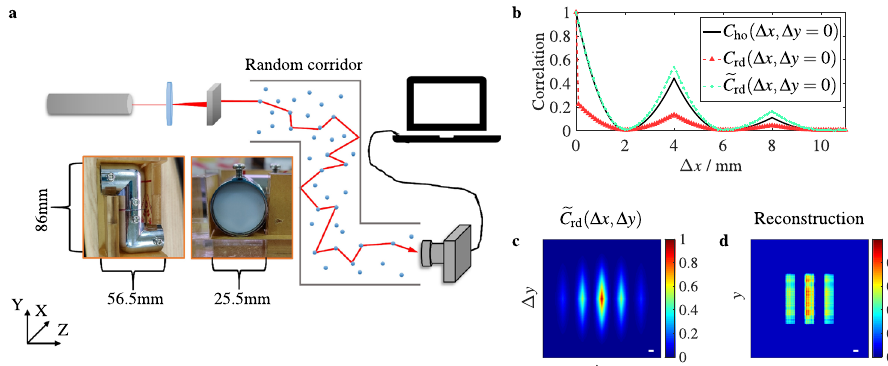
Fig. 3 Imaging in a random corridor with two corners. a Schematic of an experimental setup. b C rd , normalized e C rd and C ho vs. Δ x . C ho denotes the transmitted fi eld autocorrelation of the hidden object. c Normalized e C rd ð Δ x ; Δ y Þ . d Object image reconstructed from e C rd ð Δ x ; Δ y Þ by a phase-retrieval algorithm. System parameters for imaging: ^ l ¼ 50, R = 2.87 and N = 10 4 . Scale bar: 1 sub